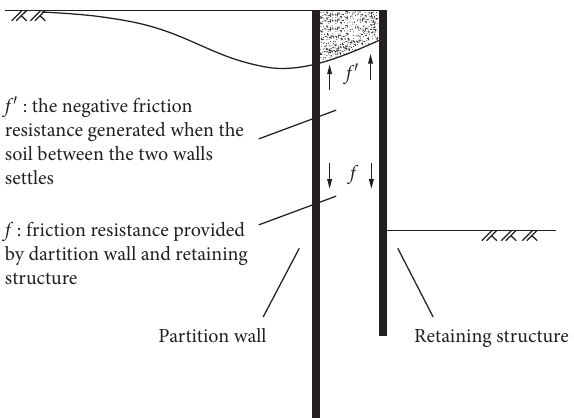
Figure 8: Schematic of the force diagram for ground settlement.